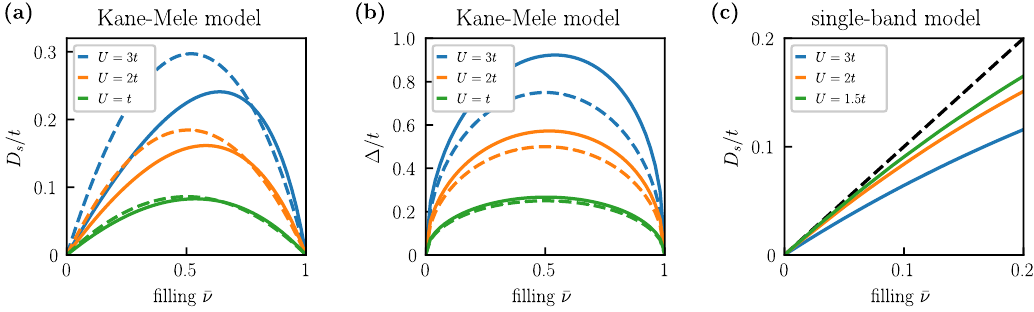
Figure 11: Comparison with analytical formulas for the clean systems in the zero- temperature limit: (a) superfluid weight D and (b) superconducting order parame- s ter ∆ of the flat Kane-Mele model for different coupling constants U as a function of the filling ¯ ν . Solid lines represent the respective quantities as obtained directly from numerics, dashed lines show the results computed using Eqs. (63) and (64), respec- tively. (c) Superfluid weight of the single-band model for different U at small fillings close to the band bottom. Solid lines are the numerical results while the dashed black line represents the analytical result using Eq. (62) assuming a parabolic